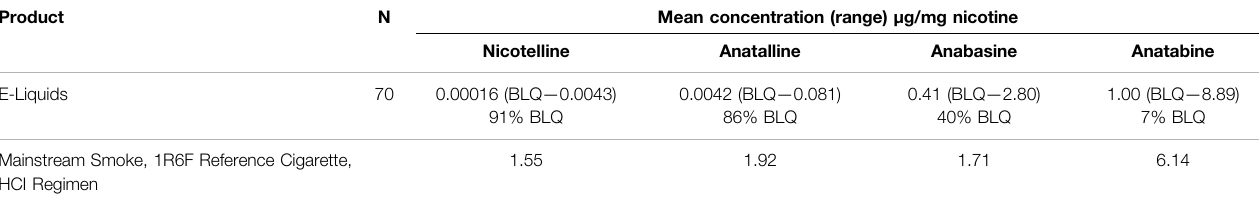
TABLE4| Meanconcentrationsofnicotelline,anatalline,anabasineandanatabine,normalizedtonicotine,in70e-liquidscomparedtothecorrespondingconcentrationsina mainstreamsmoke ofareference cigarette. BLQ =Below the limit ofquantitation. 1 Concentrations ofnicotine and theotheralkaloidswere determined bythemethodof Jacob et al. , described in reference (Jacob et al., 2020). The 70 e-liquids are also described in Supplementary Information for reference (Jacob et al.,